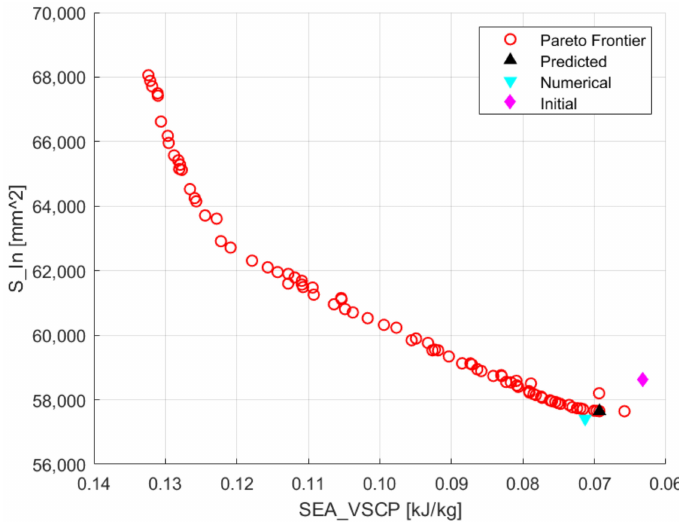
Figure 20. Pareto frontier of the multiobjective